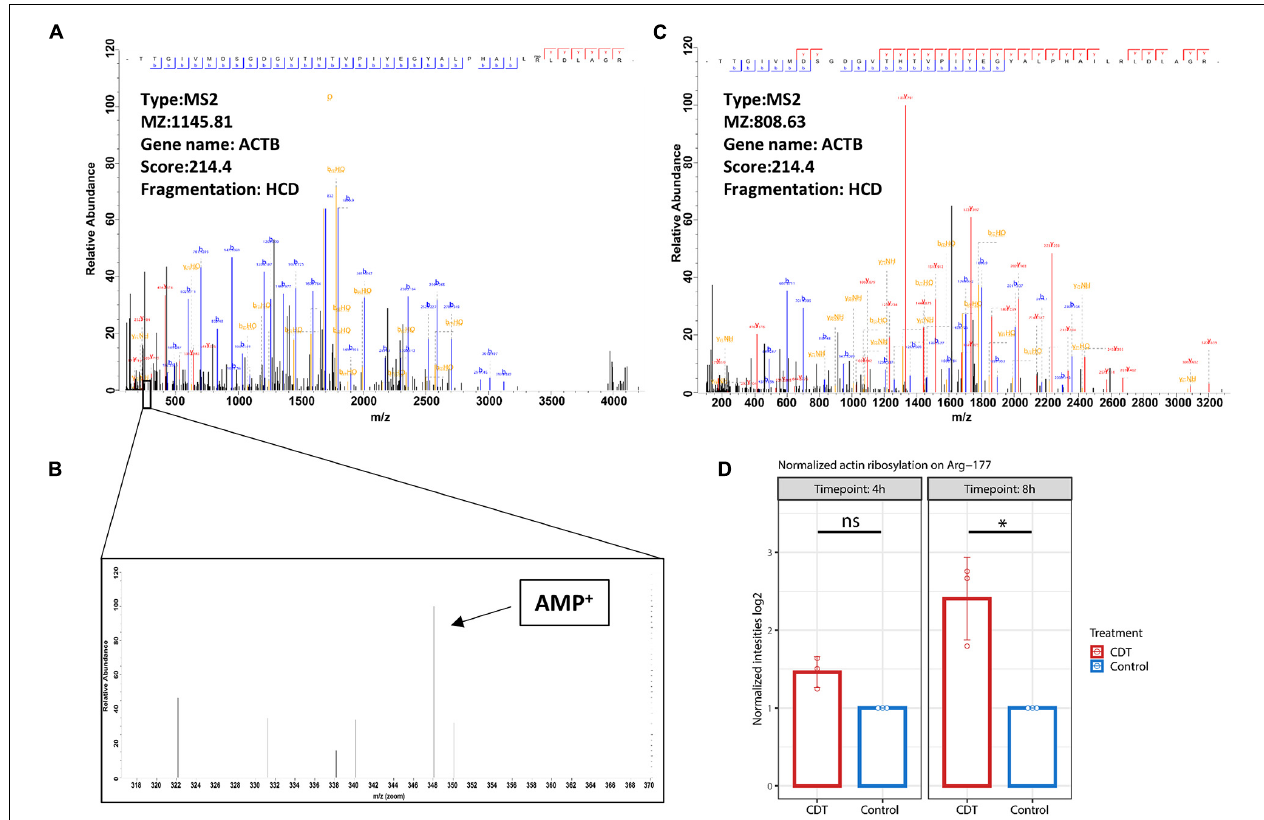
FIGURE 6 | (A) Fragment spectrum of ADP ribosylated actin on Arg-177 on the tryptic peptide TTGIVMDSGDGVTHTVPIYEGYALPHAILRLDLAGR, (C) the unmodified version, and (B) diagnostic peak of AMP at 348.2 m/z. (D) Normalized intensity of ADP ribosylation on Arg-177 after 4- and 8-h treatment with CDT (* p < 0.05, ns: